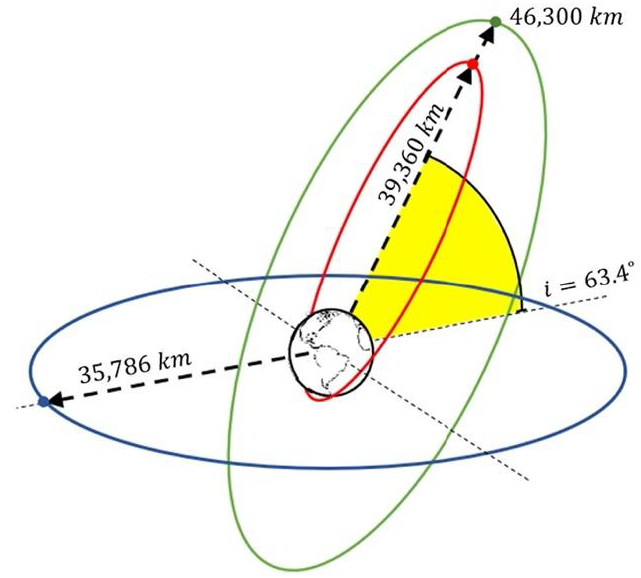
Figure 3. Potential Earth observing orbits, Molniya (Red), Tundra (Green), and Geostationary (Blue).